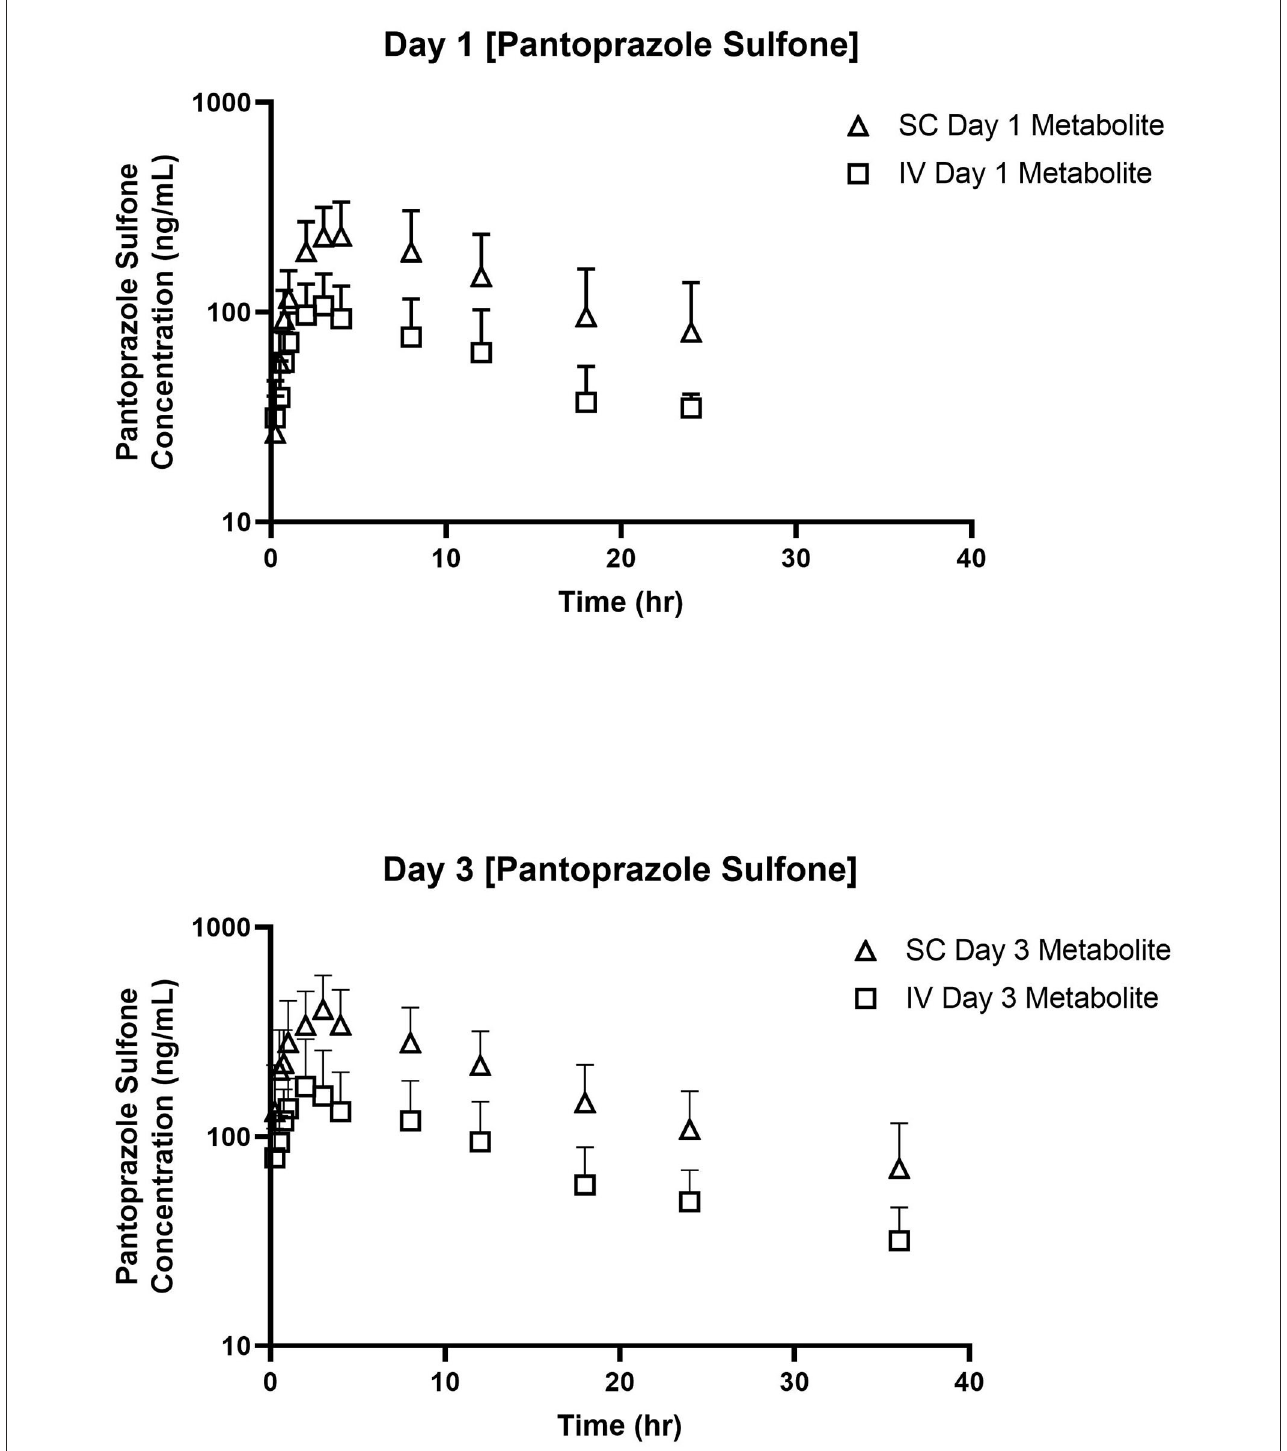
FIGURE2 Time vs. Concentration curves for pantoprazole sulfone after intravenous (IV; square) and subcutaneous (SC; triangle) administration of pantoprazole on Days 1 (top) and 3 (bottom)